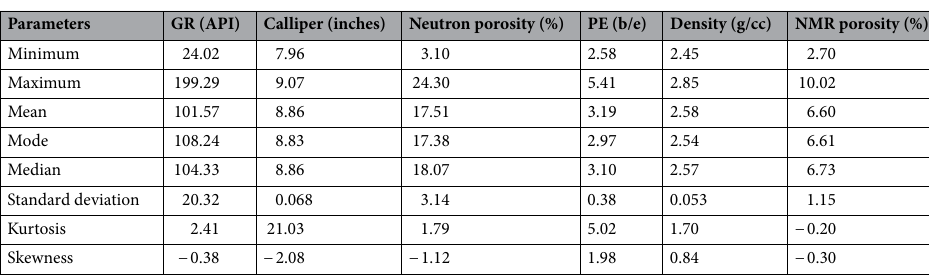
Table 1. Statistical indicators for training